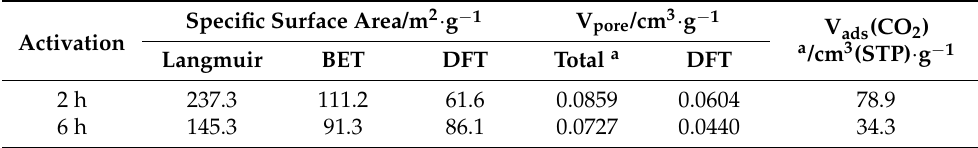
Table 2. The parameters of porous structure of compound 1